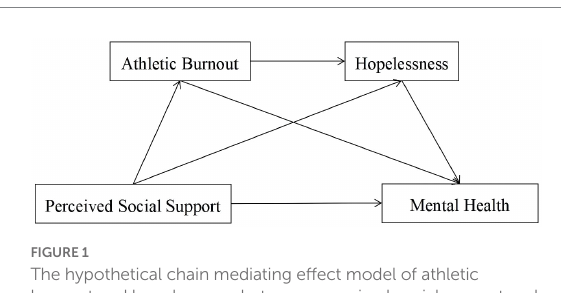
FIGURE 1 The hypothetical chain mediating effect model of athletic burnout and hopelessness between perceived social support and mental health among college soccer